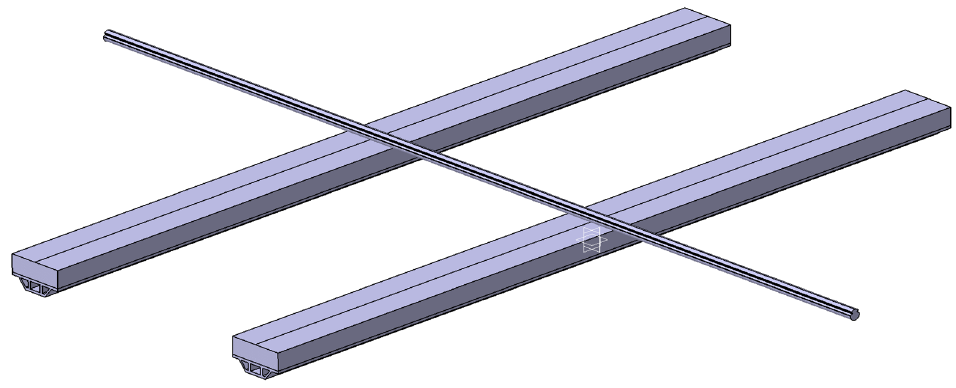
Figure 4. Arrangement of strips and contact wire for testing.